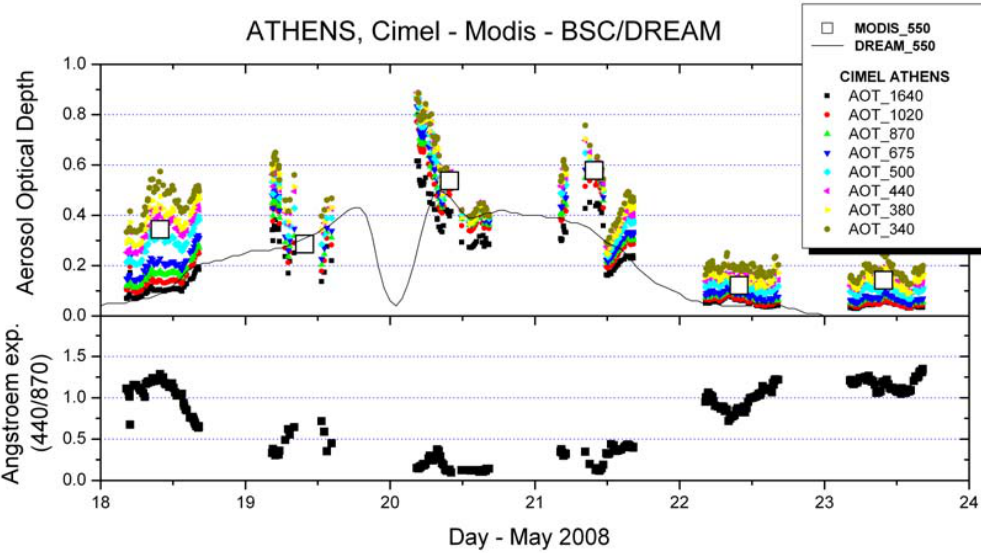
Fig. 4. Temporal evolution of the AOD at eight wavelengths over Athens for the period 18–23 May 2008 according to CIMEL sunphotometric measurements, MODIS AOD at 550nm (white squares) and BSC-DREAM dust AOD at 550nm (upper panel). Temporal evolution of the ˚Angstr¨om exponent (440–870nm) for the same time period (lower